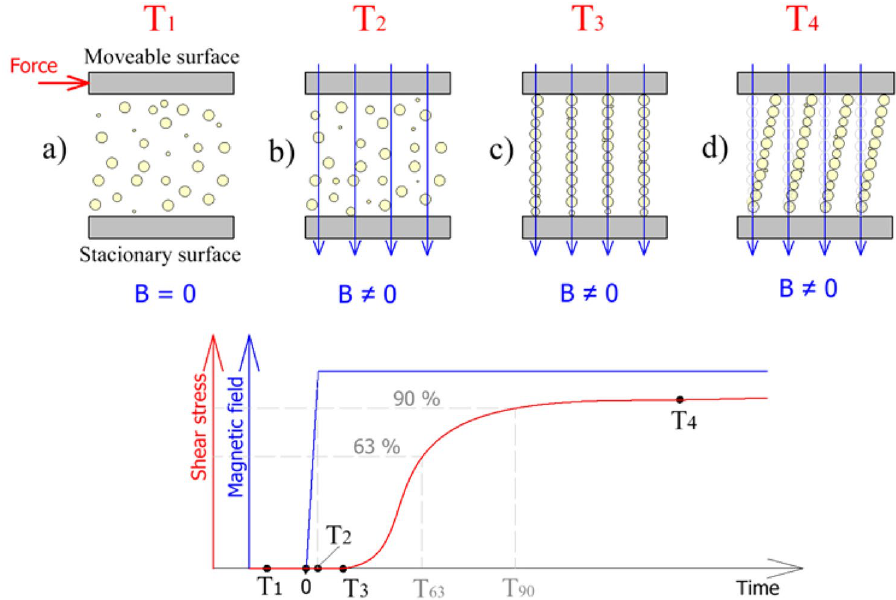
Figure 1. Demonstrating measured method and determination of time